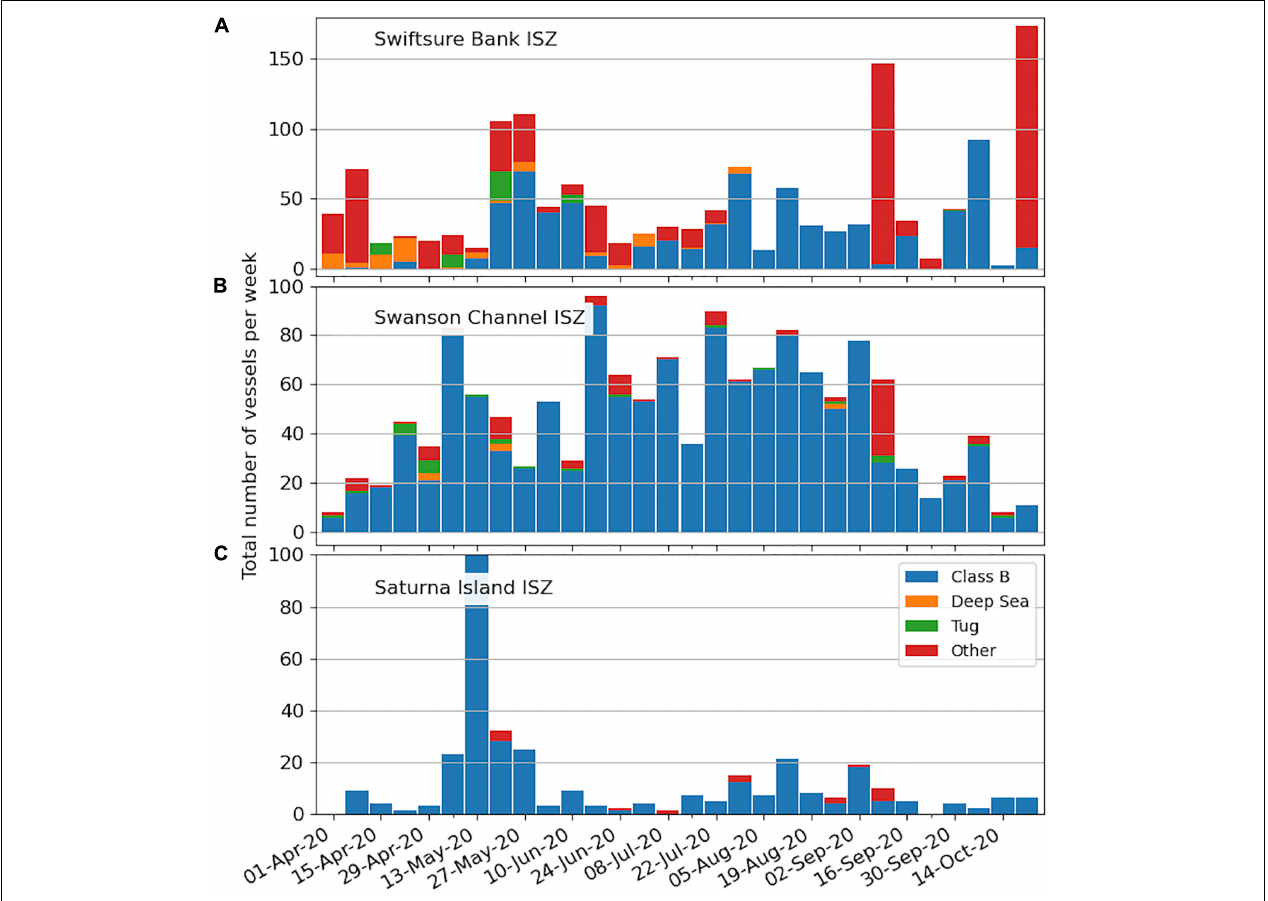
FIGURE 7 | Vessel passages within the Interim Sanctuary Zones (ISZz) at (A) Swiftsure Bank, (B) Swanson Channel, (C) Saturna Island expressed weekly from AIS data. The number of vessels, and the proportion of vessel type, is shown. Trial period for ISZs Jun. 1-Oct. 31,